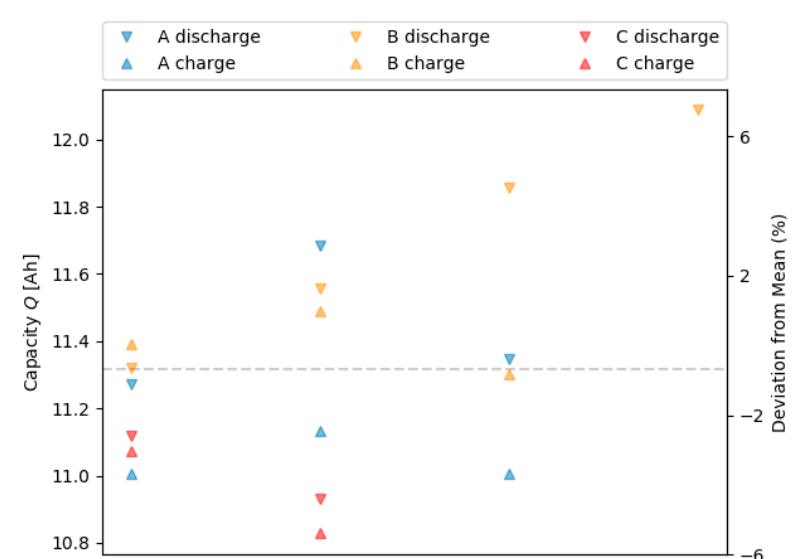
Figure 6. Typical charge and discharge cycle at constant current ( 𝐼 (cid:3003)(cid:3028)(cid:3047)(cid:3047) = ∓10 A), followed by constant voltage.